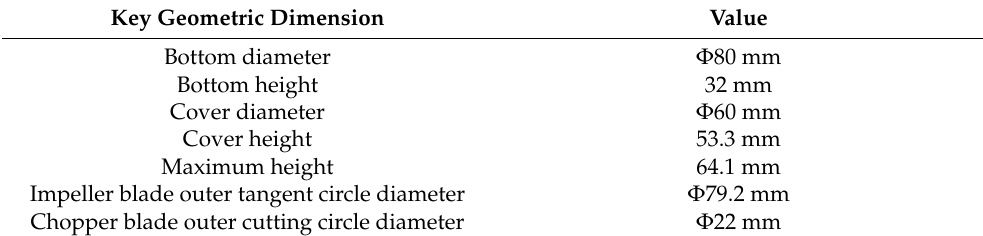
Figure 4. Schematic illustrations of vessel con fi guration ( a ) and initial loading of particles ( b ). The main dimensions are shown in Table 3. Table 3. Key geometric dimensions in the simulation model. Table 3. Key geometric dimensions in the simulation model.